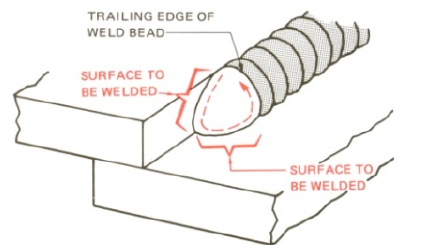
Fig. 3. Manual manner of fillet deposition [1]